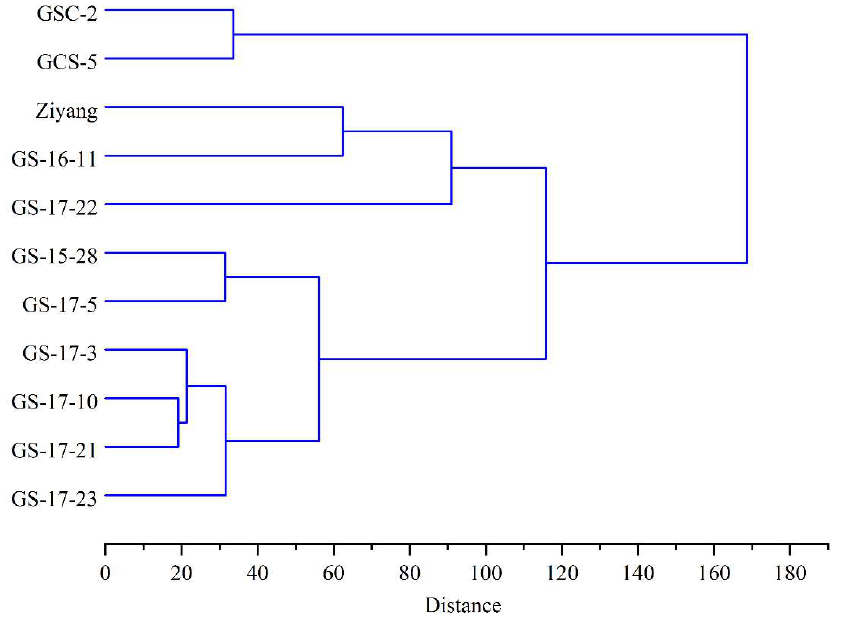
Figure 2. Cluster analysis among 11 leafy sweet potato varieties.